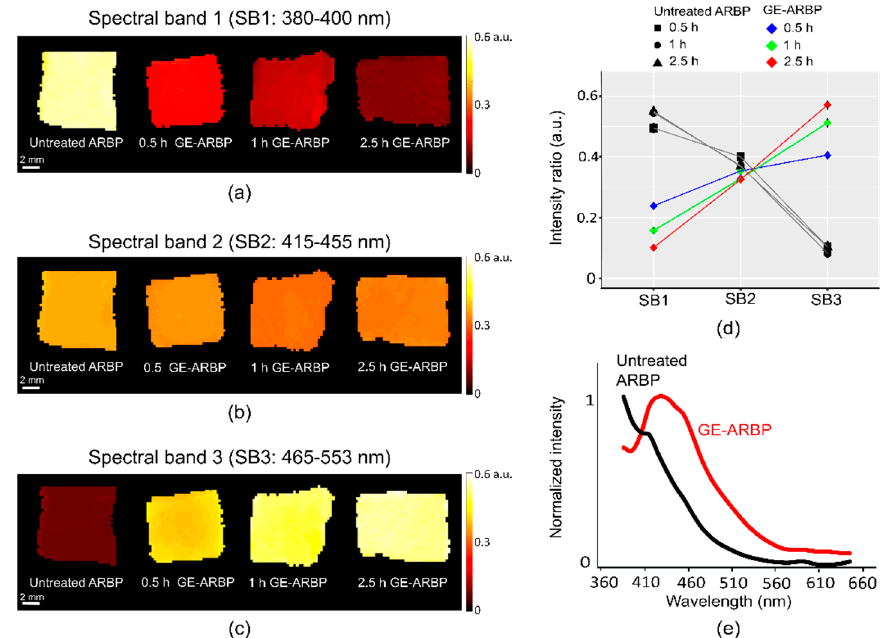
Figure 2. Intensity ratio maps of GE-ARBP (0.5 h, 1 h, 2.5 h) and corresponding untreated ARBP in SB1 ( a ), SB2 ( b ), and SB3 ( c ). ( d ) The quantified mean and standard deviation of fluorescence intensity ratios of GE-ARBP and corresponding untreated ARBP in SB1, SB2, and SB3. ( e ) Fluorescence emission spectra of untreated ARBP and GE-ARBP (2.5 h) upon 355 nm excitation.